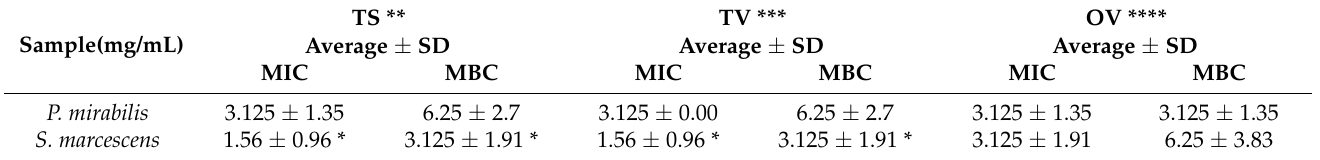
Table 3. Minimum inhibitory concentrations (MICs) and minimal bactericidal concentrations (MBCs) of selected EOs against P. mirabilis and S. marcescens.